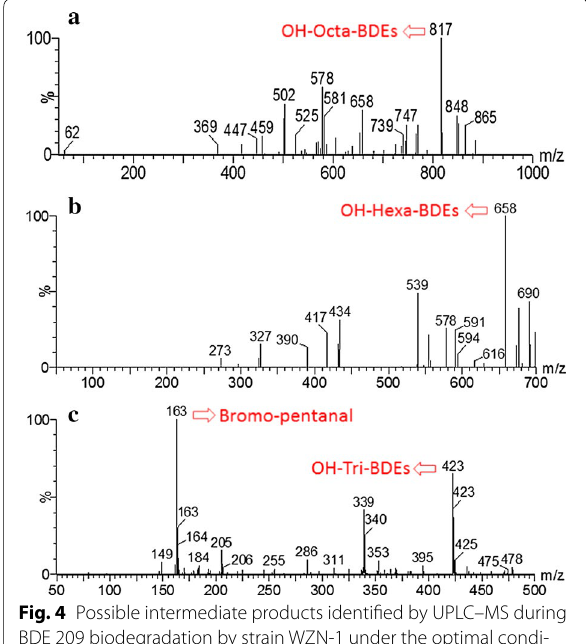
Fig. 4 Possible intermediate products identified by UPLC–MS during BDE 209 biodegradation by strain WZN-1 under the optimal condi-